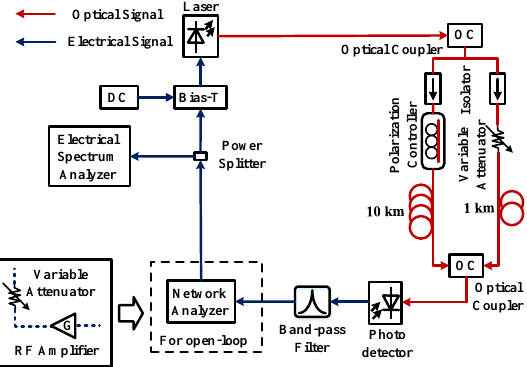
Figure 3. The schematic diagram of dual-loop optoelectronic oscillator based on open-loop gain control in [37]. OC: optical coupler. Reprinted with permission from Ref. [37], IEEE, 2018 .